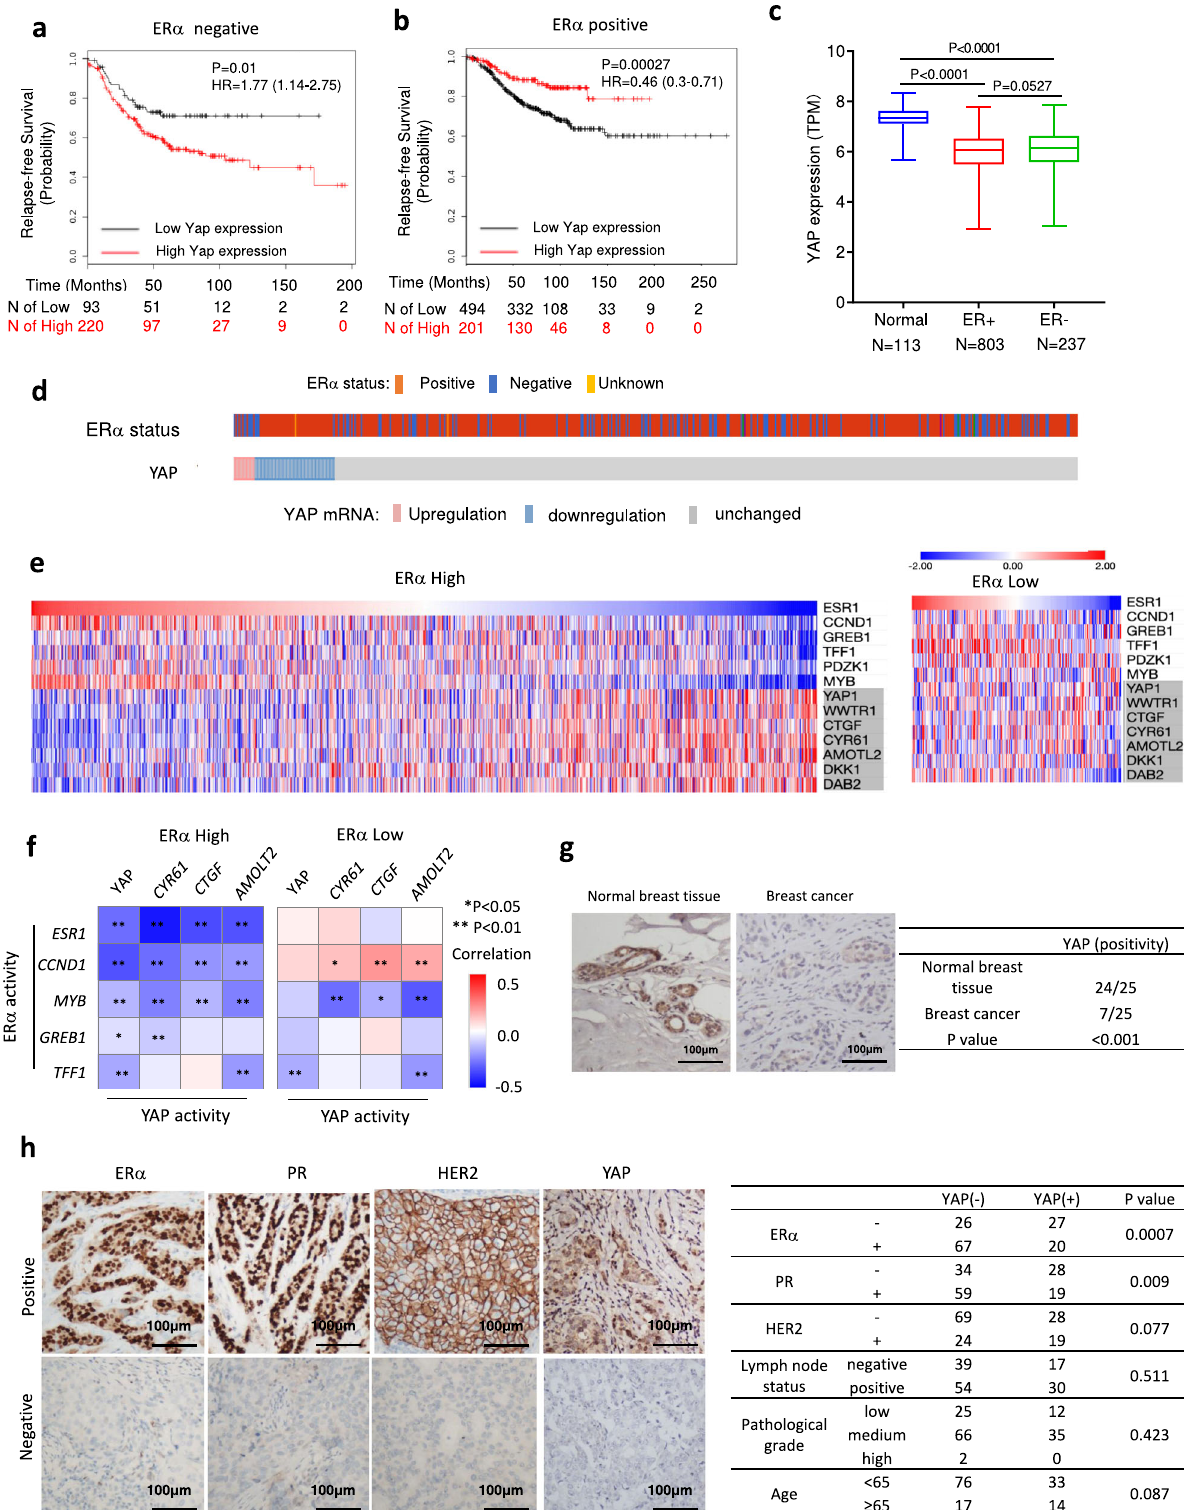
5SA (Tet-O-YAP-5SA) or its TEAD-binding defective form (Tet- treatment (Fig. 2f), suggesting that MST1/2 inhibition can reduce O-YAP-5SAS94A) 14 and derived xenografts carrying these cell ER + breast cancer growth in vivo. Examination of xenograft tumors treated with XMU-MP-1 showed elevated YAP nuclear lines. Dox-induced expression of YAP-5SA dramatically reduced localization and target gene expression (Supplementary Fig. 2e, f), tumor growth while expression of YAP-5SAS94A had no effect con fi rming the on-target effects of drug treatment in vivo. We (Fig. 2g), suggesting that YAP activation suppresses ER + breast cancer growth in vivo and does so through binding to TEAD. also generated MCF-7 cell lines stably expressing inducible YAP- NATURE COMMUNICATIONS| (2022) 13:3075 |https://doi.org/10.1038/s41467-022-30831-5|www.nature.com/naturecommunications